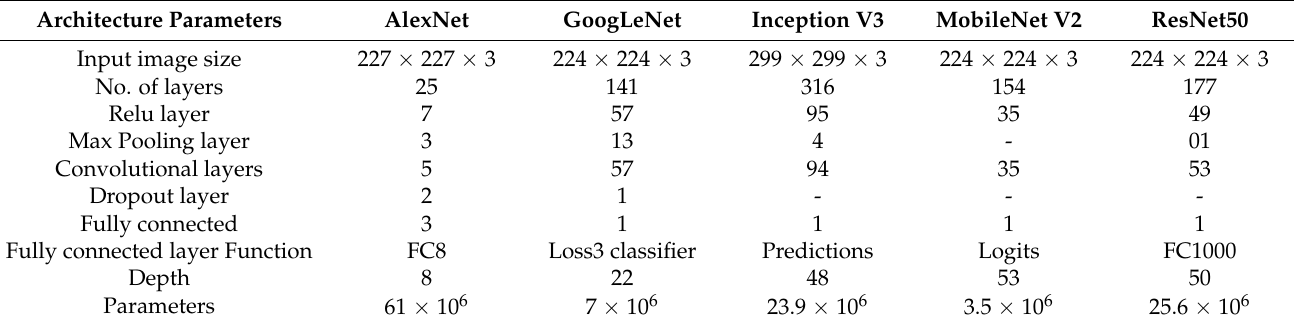
Table 1. Architecture parameters in the feature extraction-based models for crop water stress